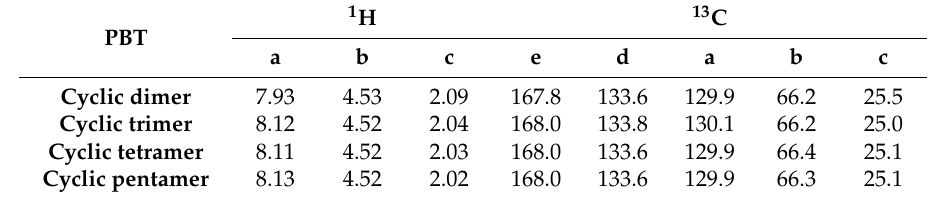
Table 3. Chemical shifts in ppm for 1 H and 13 C NMR spectra of four PBT oligomers according to signal attribution of